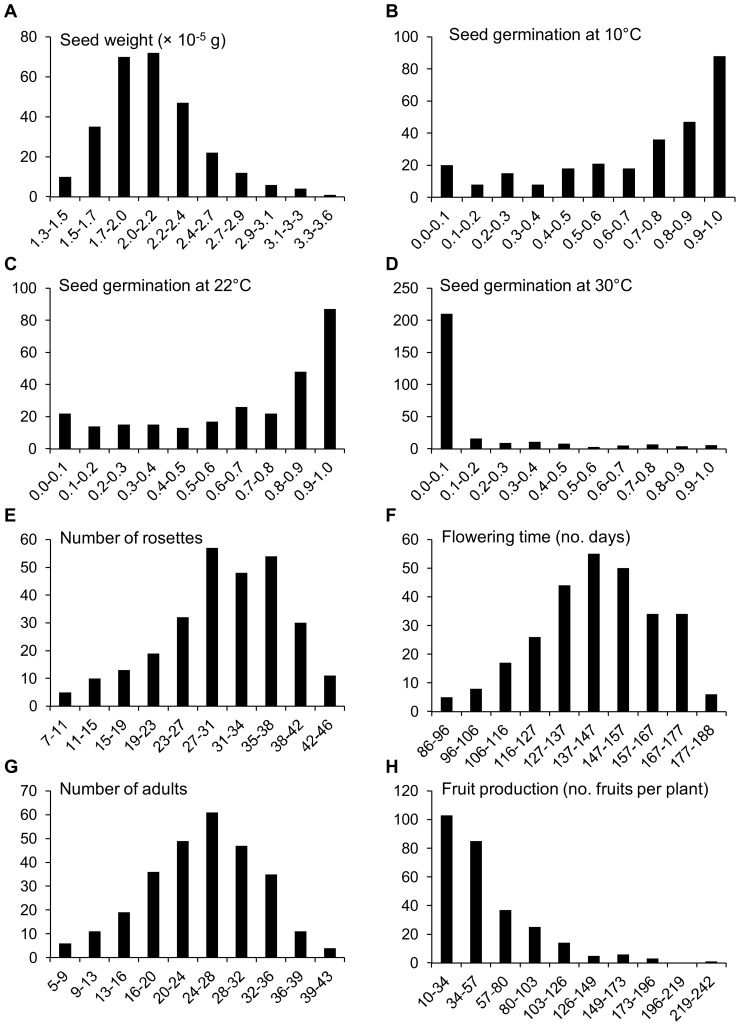
Frequency distributions for life-history traits of A. thaliana.Graphs depict the number of accessions within each interval. N = 279 accessions in all cases.